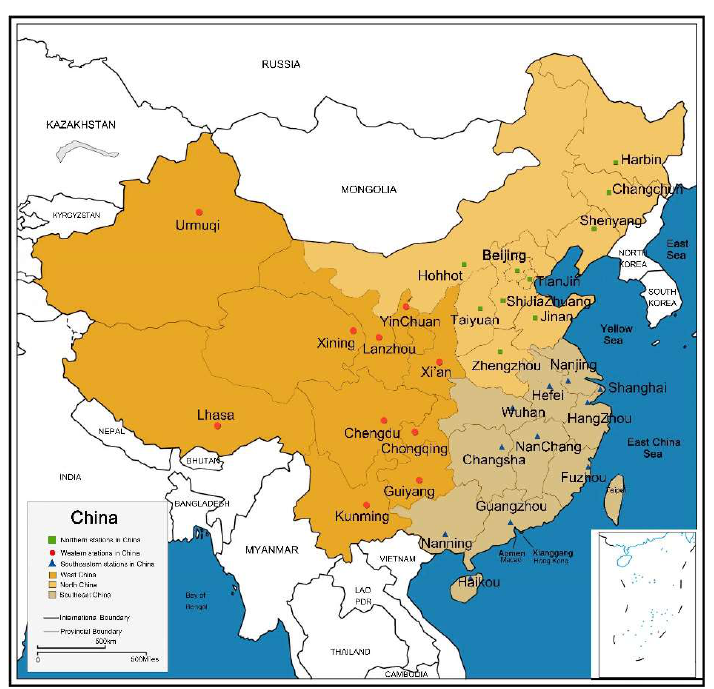
Figure 1. Locations of 31 provincial capital cities in China.